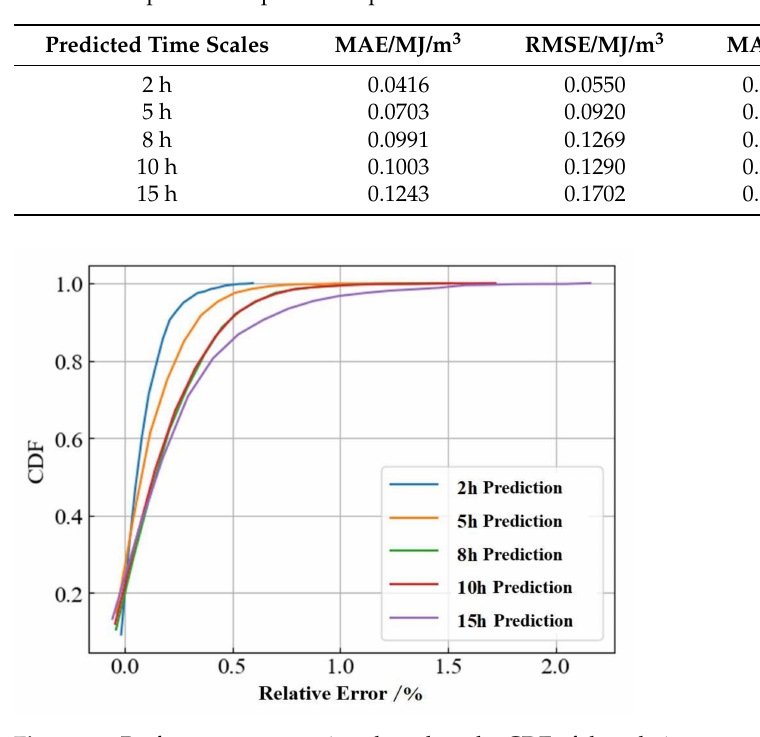
Figure 13. Performance comparison based on the CDF of the relative error of prediction